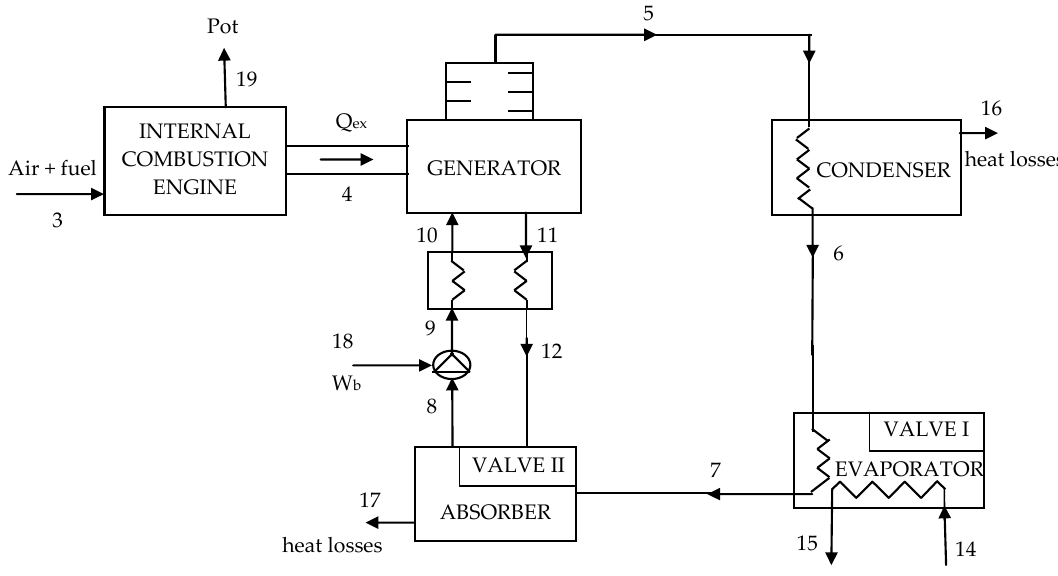
Figure 1. Scheme of the compact cogeneration module.